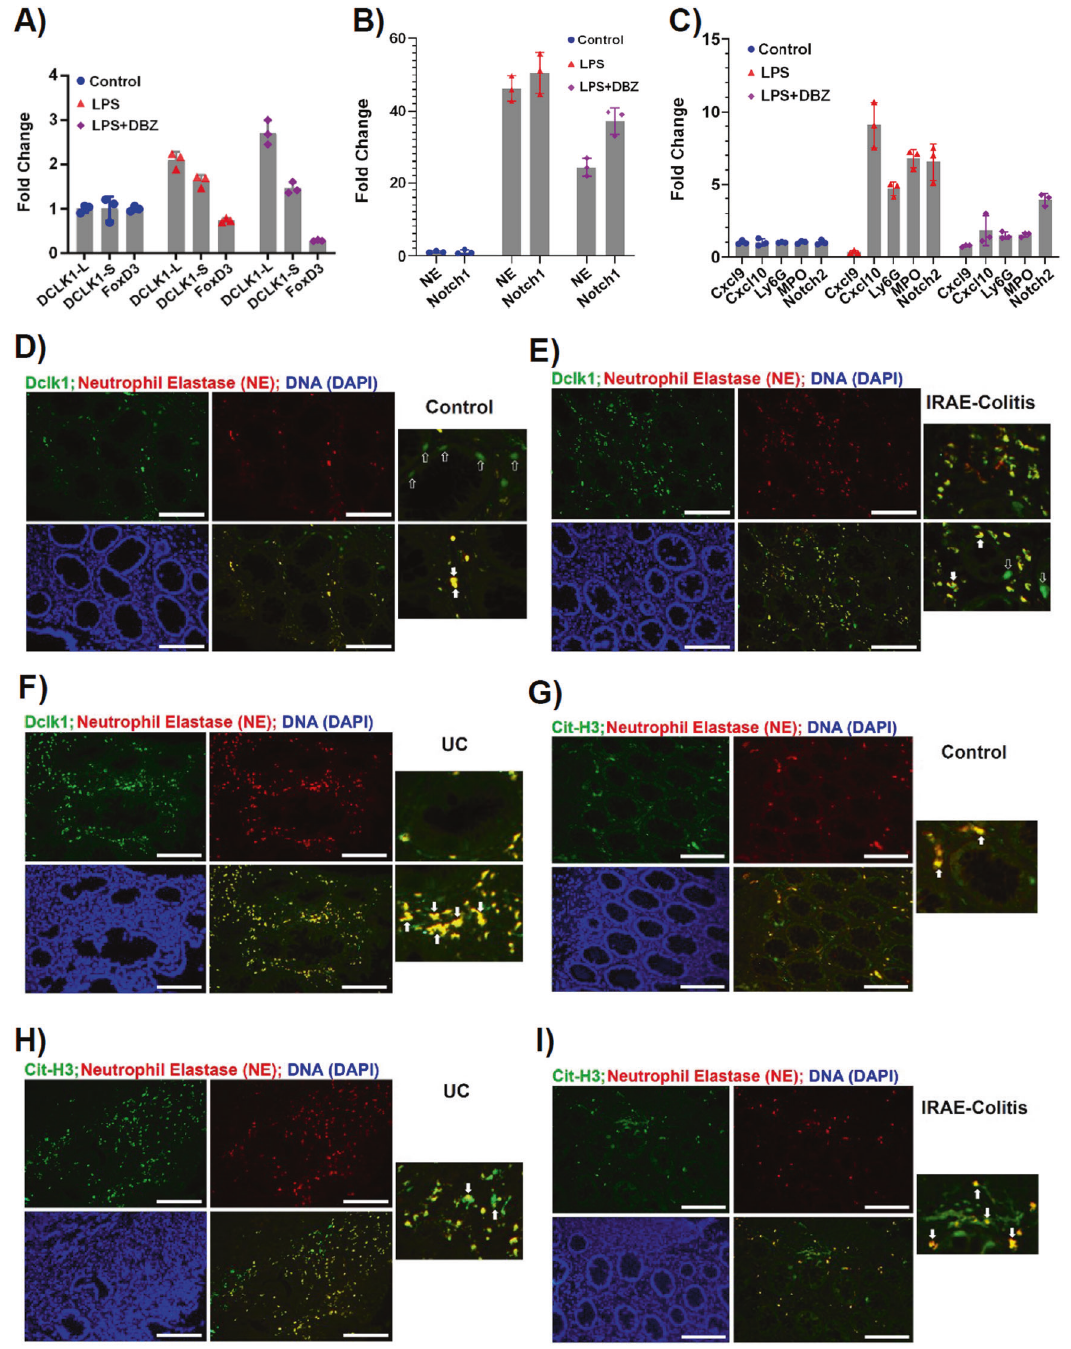
Fig. 8 Evidence of neutrophil extracellular trap formation in vivo. A – C Human neutrophils were cultured in the presence or absence of LPS or LPS + DBZ for 8 h and the expression of indicated markers was determined by RT-qPCR and the data are presented as fold change after normalizing values to GAPDH. P values for A based on signi fi cance (LPS vs. control): 0.000734 (DCLK1-L), 0.023915 (DCLK1-S), 0.004097 (FoxD3); LPS + DBZ vs. LPS: 0.000525 (DCLK1-L), 0.057920 (DCLK1-S), 0.000035 (FoxD3). P values for B based on signi fi cance (LPS vs. Control): 0.000024 (NE), 0.000115 (Notch1); LPS + DBZ: 0.000083 (NE), 0.000075 (Notch1). P values for C based on signi fi cance (LPS vs. Control): 0.003059 (CXCL9), 0.000883 (CXCL10); LPS + DBZ vs. LPS: 0.007031 (MPO), 0.000315 (Notch2). D – I Paraf fi n-embedded sections from control or UC and immune-related adverse event — colitis (IRAEC) patients were co-stained with antibodies for DCLK1/NE or NE/Cit-H3, respectively. Solid arrows provide evidence of co-localization; open arrows point to DCLK1 + cells that did not co-localize with NE (Scale bar = 150 μ m; n = 2 independent wherein we observed interleukin-6-induced increases in both DCLK1-L isoform (Fig. 7D), particularly in the Ly6G + cells in the CR DCLK1-L and DCLK1-S promoter reporter activities, respectively group, and its expression was not affected by DBZ (Fig. 7D). To (Fig. S5C). Taken together, CDX2-Cre -dependent KO of epithelial see whether the two isoforms can also be regulated by DCLK1 does not preclude accumulation of the two isoforms within proin fl ammatory cytokines, we next performed an in vitro assay